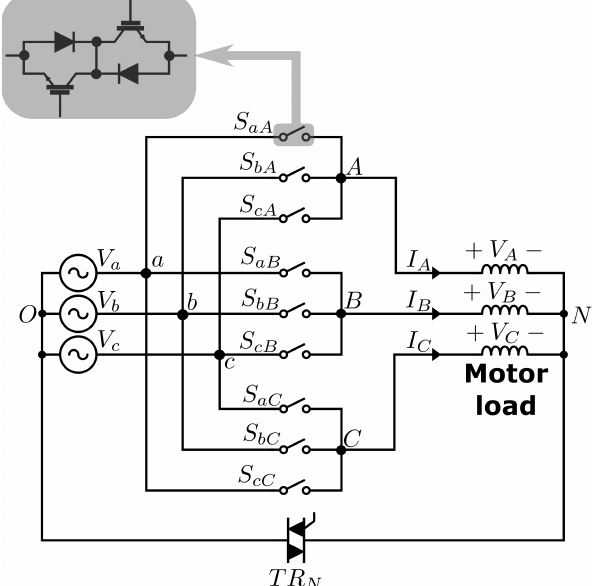
Figure 17. Fault-tolerant single-phase matrix PEC. Fault compensation is achieved by reconfiguring the matrix topology with the help of a switching device ( TR N ). Based on the redefined structure of the converter, a fault-tolerant modulation algorithm is developed to reshape the output currents of the two non-fault phases to obtain continuous